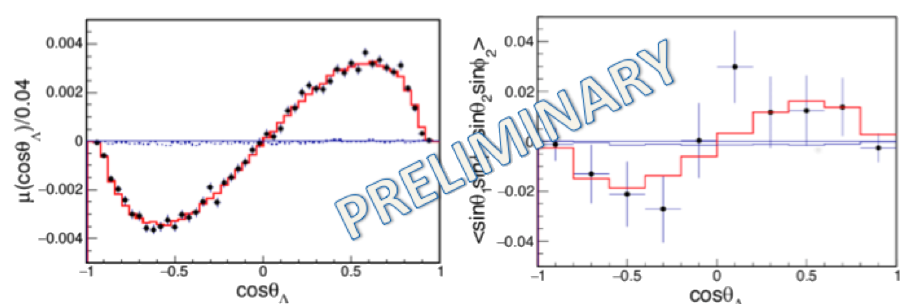
Figure 1. Moments µ (cos θ Λ ) as function of cos θ Λ for the process e − e + → J /ψ → Λ ( → p π − ) ¯ Λ ( → ¯ p π + ) √ s = 2 . 396 GeV (left) and e − e + → γ ∗ → Λ ¯ Λ at